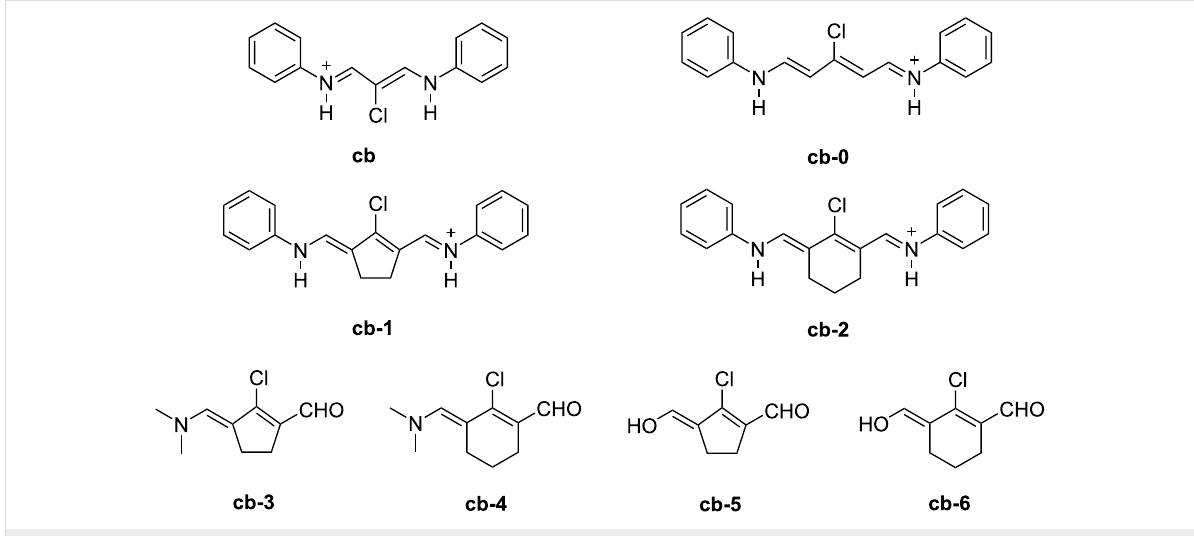
Scheme 4: Structure of alternative chain builders for synthesis of heptamethines.